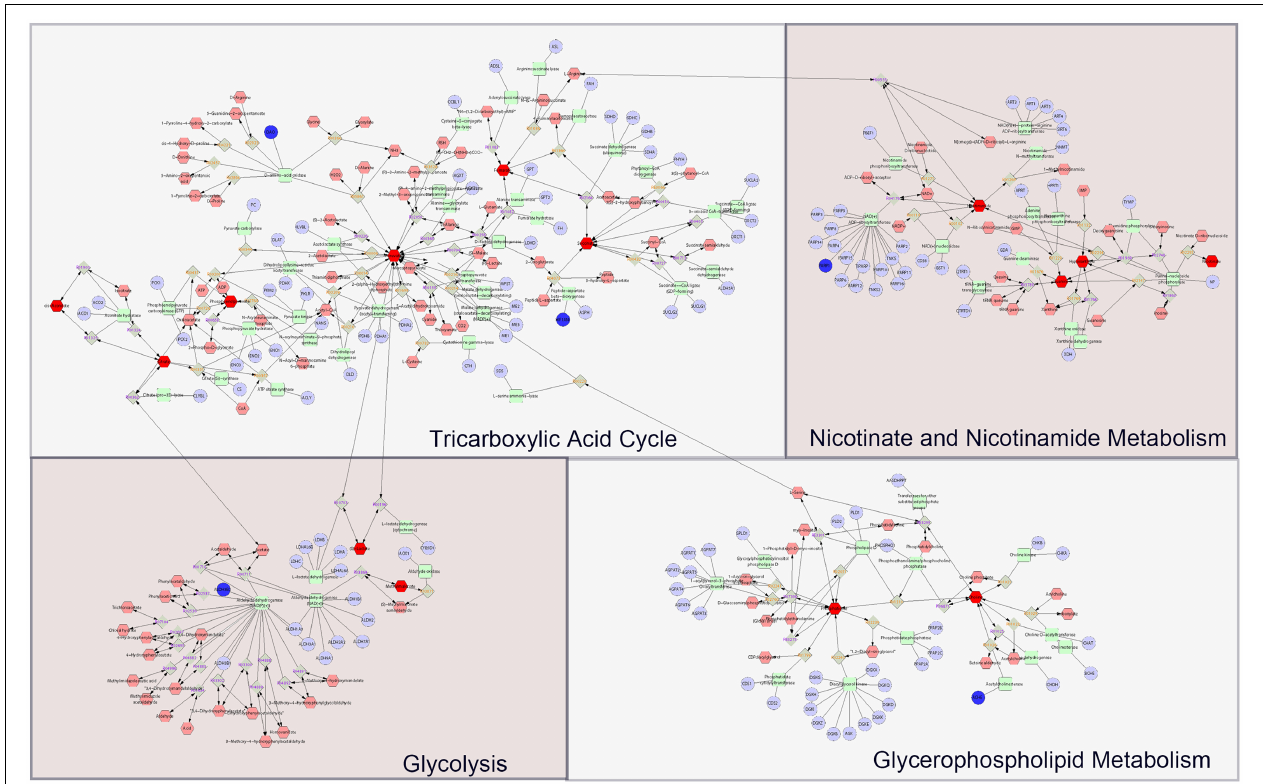
FIGURE 6 | The compound-reaction-enzyme-gene networks based on the key metabolites and targets of DHYZ against AD. The faint red hexagons, gray diamonds, green round rectangle, and purple circles represent the compounds, reactions, proteins, and genes, respectively. The scarlet hexagons and dark blue circles represent the key metabolites and target genes of DHYZ against AD. AD, Alzheimer’s disease; DHYZ,